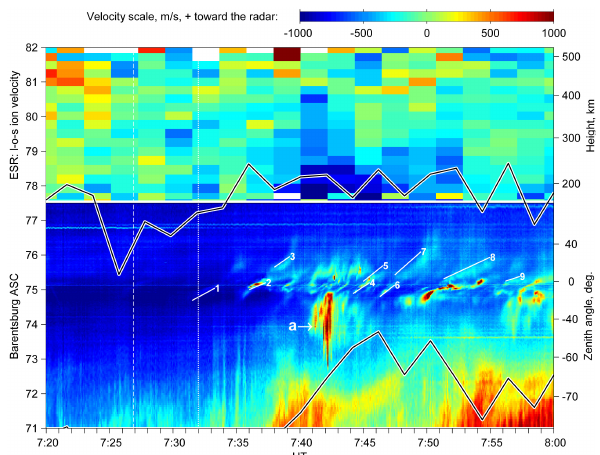
Fig. 6. A keogram from the Barentsburg TV observations (for the same meridian as the UVI data of Fig. 5) and the incoherent scat- ter radar l-o-s velocity observed poleward of the TV camera field of view. White vertical dashed and dotted lines indicate the mo- ments of the pulse arrival to the bow shock and its detection at the low-latitude magnetic observatory Bangui, respectively. Black lines indicate the position of the middle part and the poleward boundaries of the auroral oval. Numbers 1–9 and letter “a” label individual au- roral